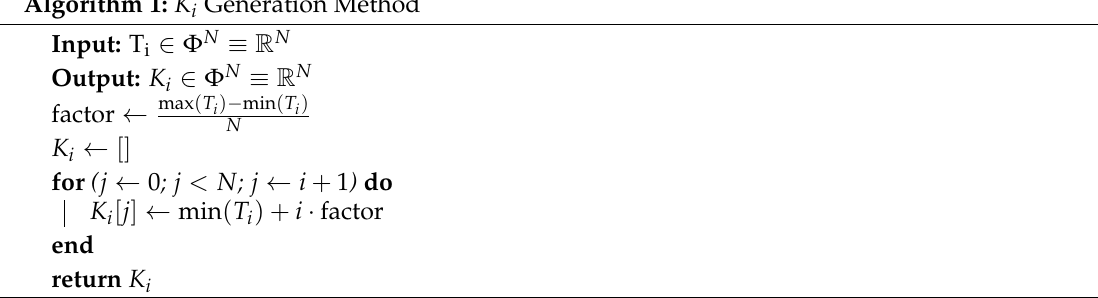
Algorithm 1: K i Generation